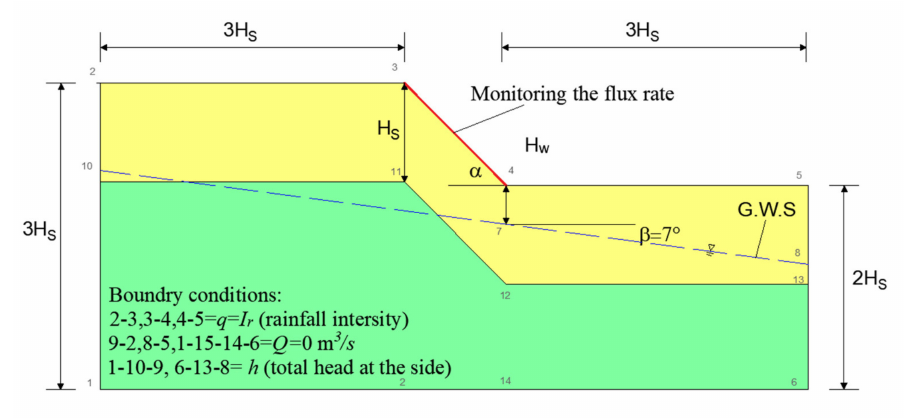
Figure 3. Schematic diagram and the boundary conditions for the seepage